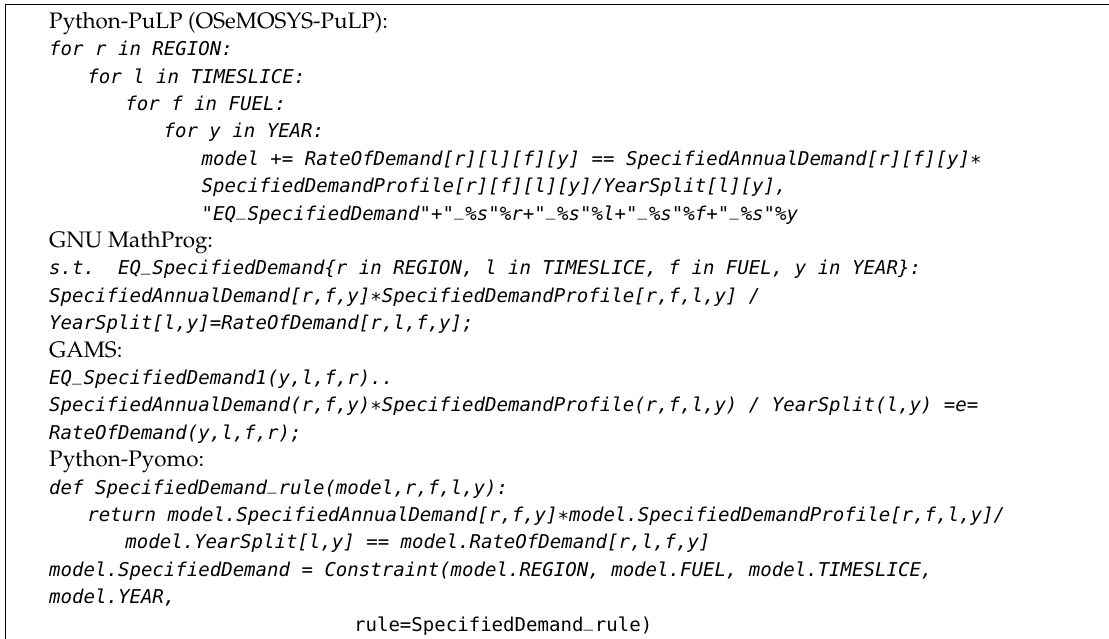
Box 1. Comparison of the syntax of all code implementations of the OSeMOSYS modeling